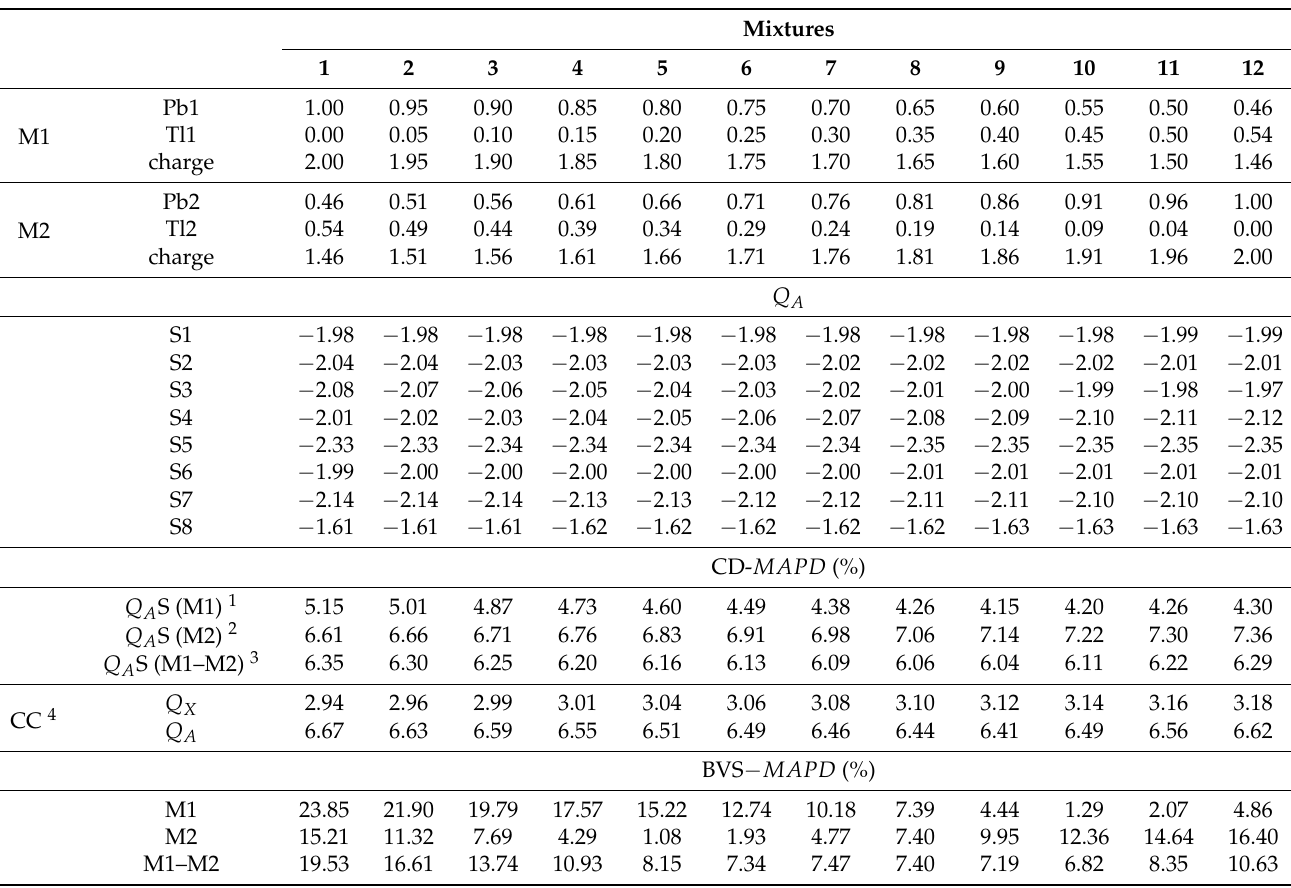
Table 1. Total Q A charges received by the sulfur atoms and MAPD s for various virtual mixtures of Pb and Tl, in the Pb1–Tl1 (M1) and Pb2–Tl2 (M2) positions of the ‘rath7’ crystal structure (Topa